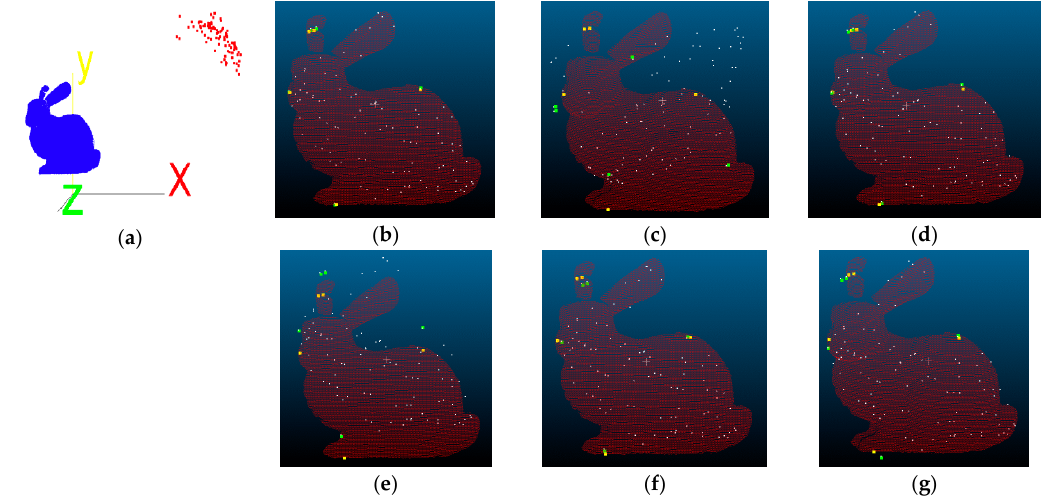
Figure 7. Stanford Bunny alignment results: ( a ) initial positions; ( b ) I-ICP; ( c ) PCL-ICP; ( d ) Go-ICP; ( e ) CPD-ICP (rigid); ( f ) CPD-ICP (affine); and ( g ) CC-ICP. Table 1. Comparisons of Root-Mean-Square errors.